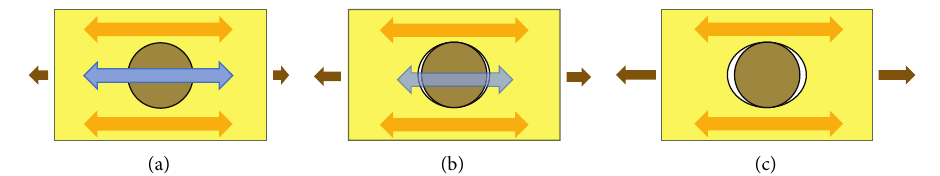
Figure 4: Detachment process of CR particles and base asphalt in elastic recovery experiment. (a) No detachment, (b) partial detachment, and (c) completely